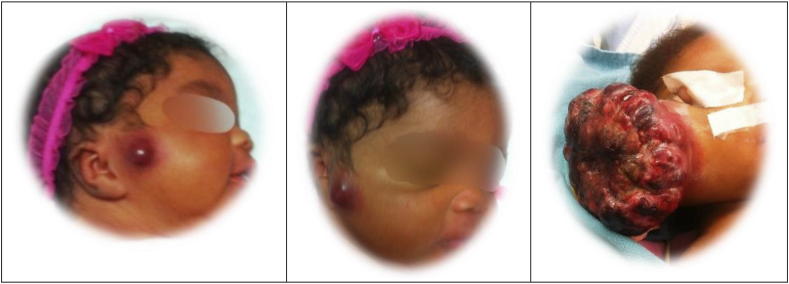
Photos of infant.